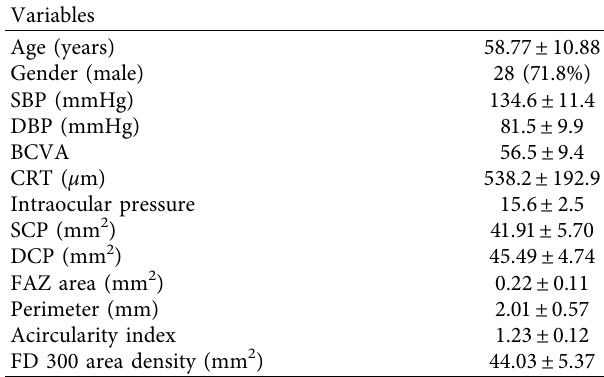
Table 1: Baseline demographics and ocular characteristics of participants.